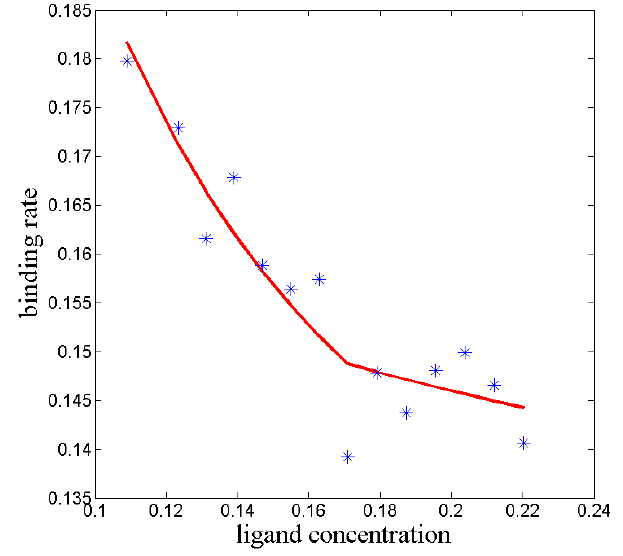
Figure 4. In a kinetic ITC experiment the ligand concentration ( mM ) in solution increases stepwise via titration. From the ligand concentration and from the electric power which is used to keep the temperature constant, the binding rate of the process can be calculated ( mM − 1 s − 1 ). The blue stars represent experimental results taken from [41]. If the binding would be a one-step molecular process, then the rate should be constant number. The systematic decrease of the rate can be explained by assuming a projection from a multivalent reaction kinetics model onto a 2-dimensional invariant subspace of L (red